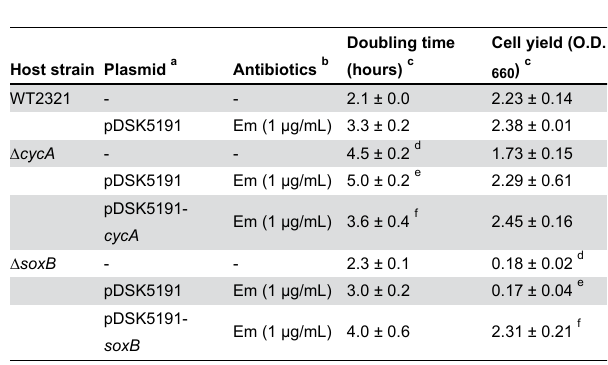
Table 4. Growth profiles of the C. tepidum transconjugants.